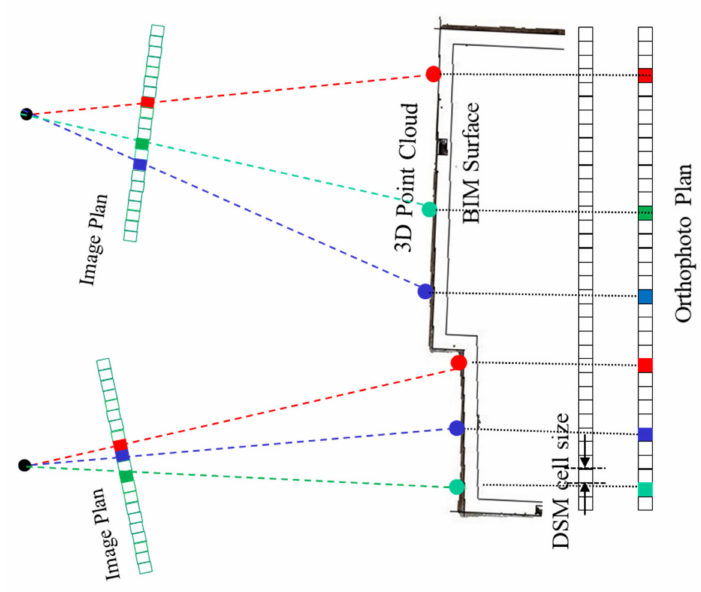
Figure 20. True orthophoto